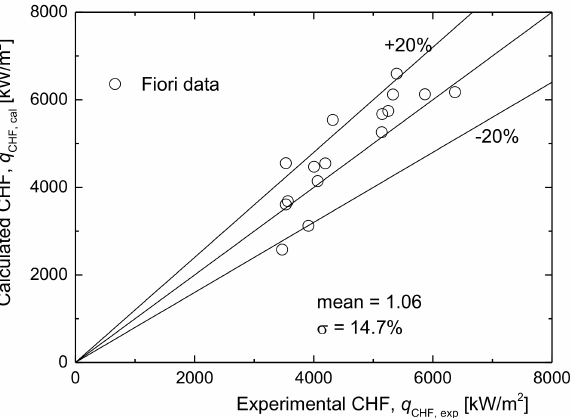
Figure 5. CHF prediction in an annulus using Fiori data (Levy model for NVG